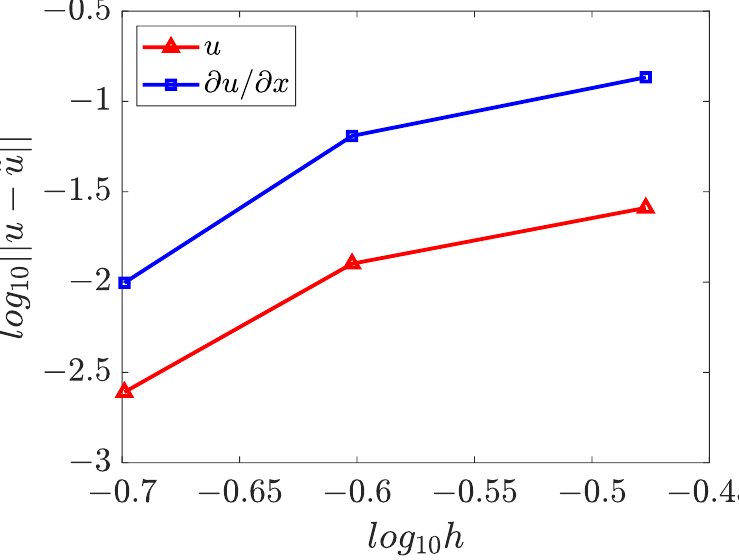
Figure 29. Solution and corresponding error of wave number k for the 3D parameter identification problem in spherical domain under different discretizations: ( a ) N s = 7 × 7 × 7; ( b ) N s = 9 × 9 × 9; ( c ) N s = 11 × 11 × 11.